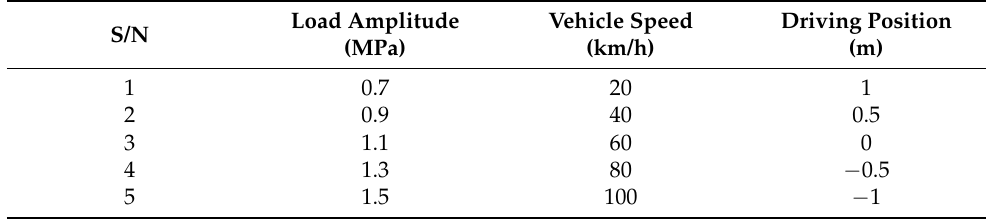
Table 4. Condition setting